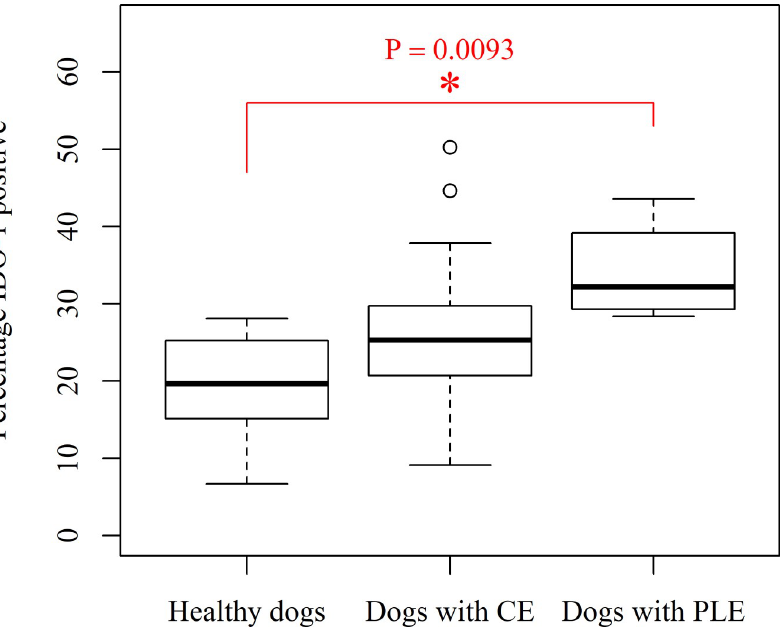
Fig 1. Box and whisker plot of percentage mucosal IDO-1 positive mRNA in the duodenum of dogs with protein- losing enteropathy (PLE), chronic enteropathy (CE) and healthy Beagle dogs. Dogs with PLE– 6 dogs, median– 32.18, interquartile range- 11.19. Dogs with CE– 18 dogs, median– 25.28, interquartile range- 9.56, healthy Beagle control dogs- 8 dogs, median– 19.65, interquartile range-